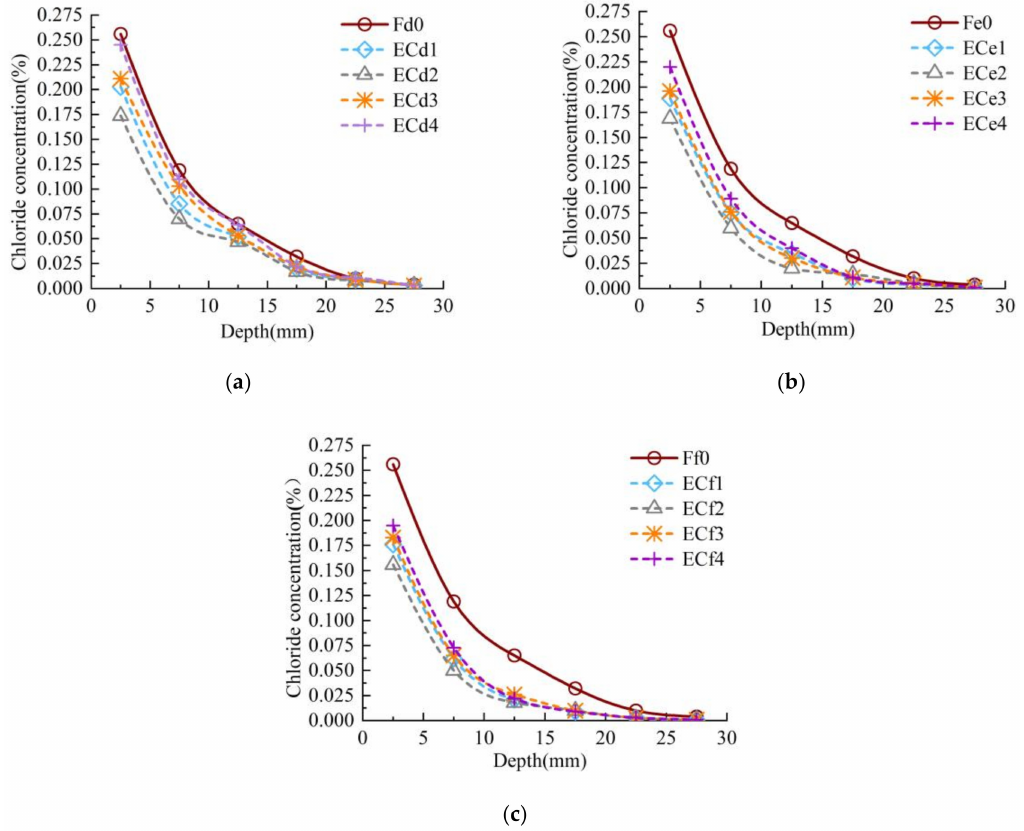
Figure 5. Chloride concentration distribution of concrete with three w / c ratios under biaxial sustained stress: ( a ) w / c = 0.44; ( b ) w / c = 0.4; ( c ) w / c =